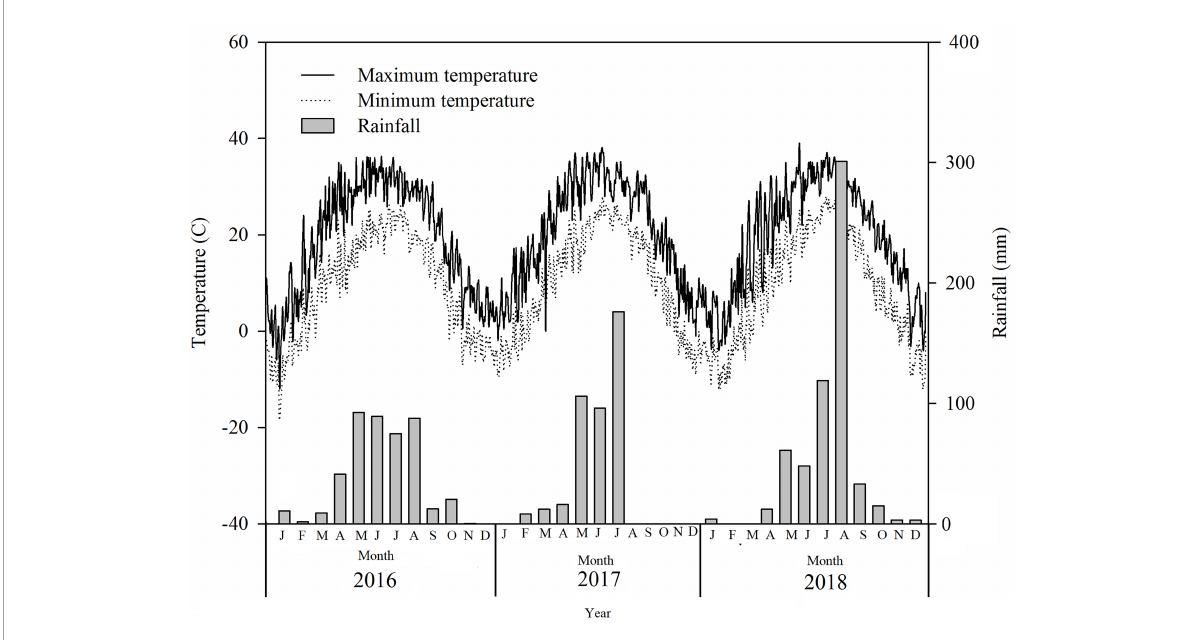
FIGURE1 Rainfall and temperature in the experimental sites in 2016, 2017, and